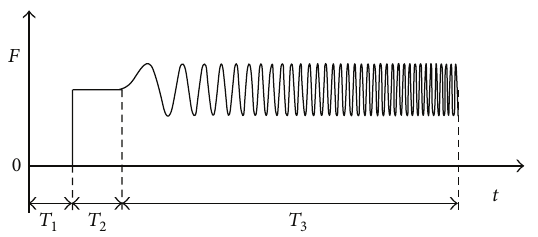
Figure 8: Loading scheme of dynamic stiffness measurement.